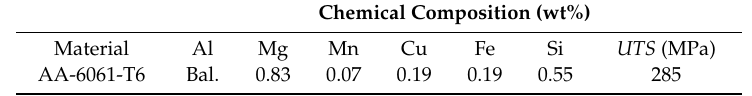
Table 1. Chemical composition and tensile strength of the base metal.